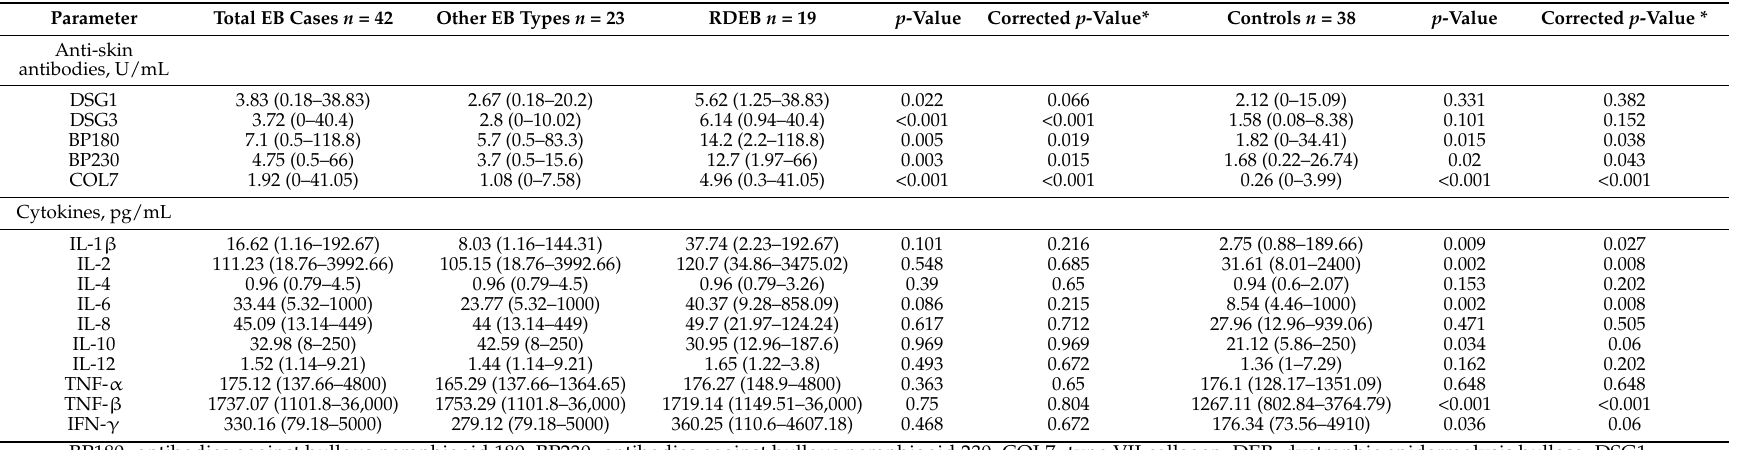
Table 2. Comparison between different inherited epidermolysis bullosa types and healthy